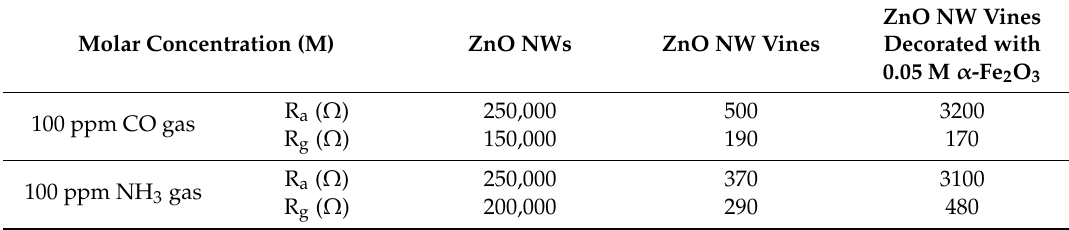
Table 1. Resistance of the ZnO NWs, ZnO NW vines, and ZnO NW vines decorated with 0.05-M α -Fe 2 O 3 to 100 ppm CO or NH 3.